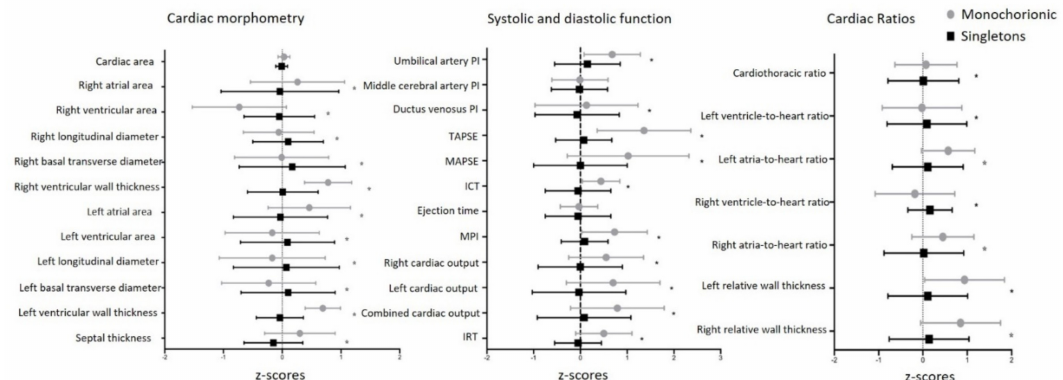
Figure 2. Forest plots for z-scores (mean and standard deviation) of cardiac morphometric parameters, functional systolic parameters and functional diastolic parameters and cardiac ratios. * Statistically significant results. PI: pulsatility index; TAPSE: tricuspid annular plane systolic excursion; MAPSE: mitral annular plane systolic excursion; ICT: isovolumetric contraction time; IRT: isovolumetric relaxation time.